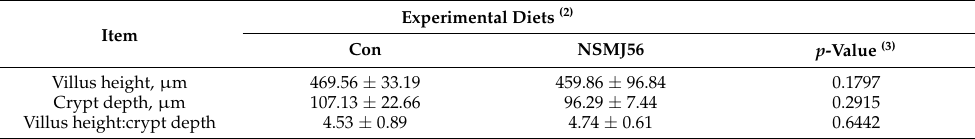
Table 4. Effects of L. paracasei NSMJ56 on small intestine morphology in early-age broiler chickens (1) .